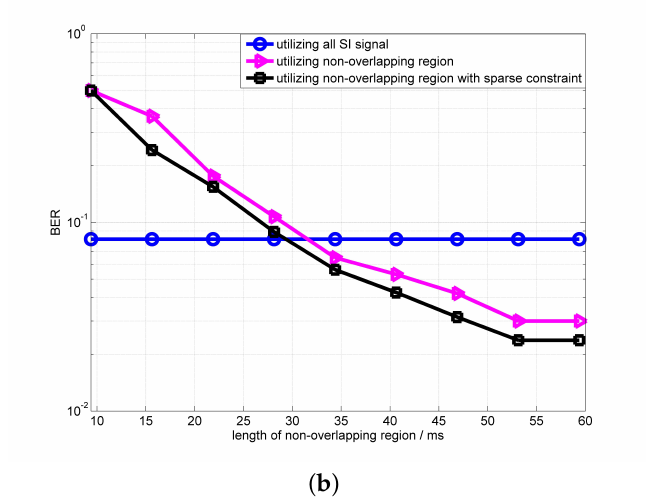
Figure 15. The convergence performance of the OPRLS with sparse constraint ( a ) SIR = − 10 dB; ( b ) SIR = − 20